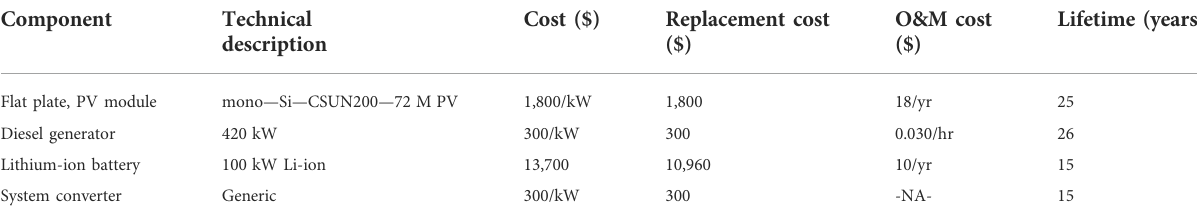
TABLE 4 Techno-economic data for system